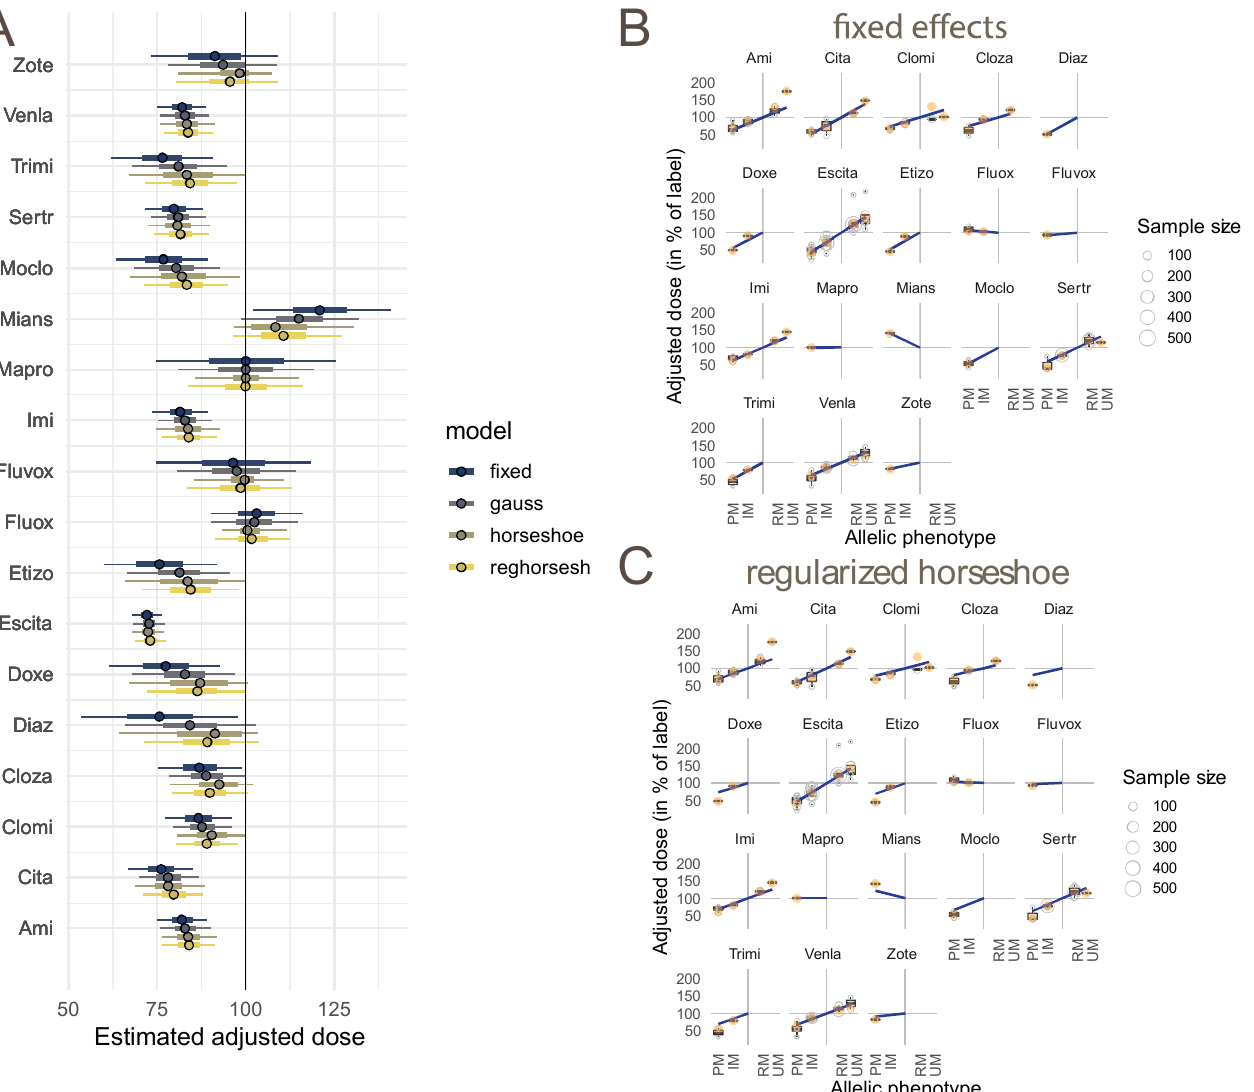
Figure 2. ( A ) Comparison of estimated dose adjustments and confidence intervals for the IM pheno- type in the fixed-effects model, the Gaussian random-effect, and the two versions of the horseshoe. ( B ) Fixed-effects model: slopes of effects of activity scores in individual substances (blue), together with estimates of adjustment computed with the traditional approach of means computed at each combination of phenotype group and substance, separately (in orange). On the x axis, the four phenotypic groups for which adjustment was estimated; on the y axis, estimated adjusted dose (in % of label dose). ( C ) As in B, regularized horseshoe model.